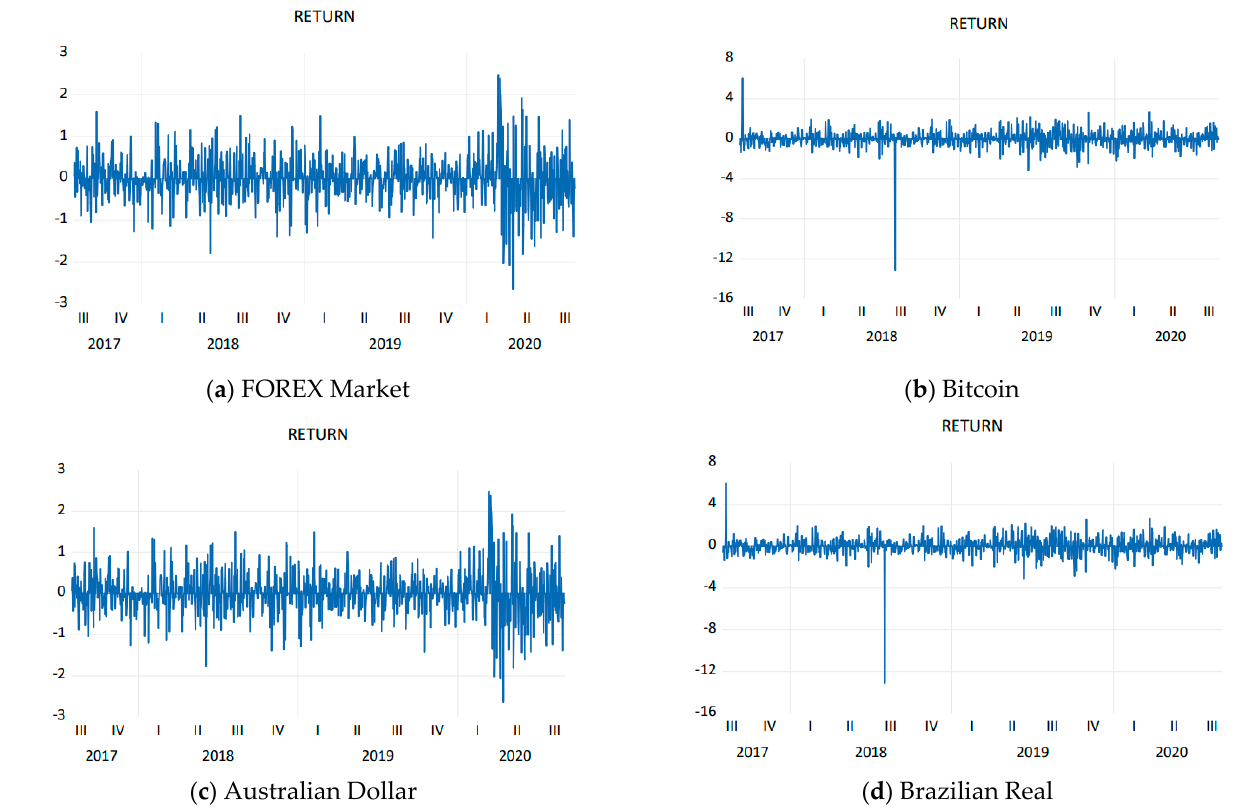
Figure 5. Volatility of FOREX Currencies.